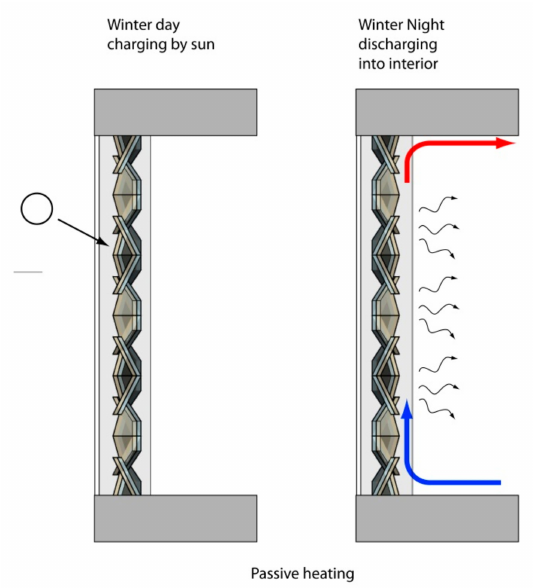
Figure 1. Double Face 2.0 Trombe wall winter operation mode